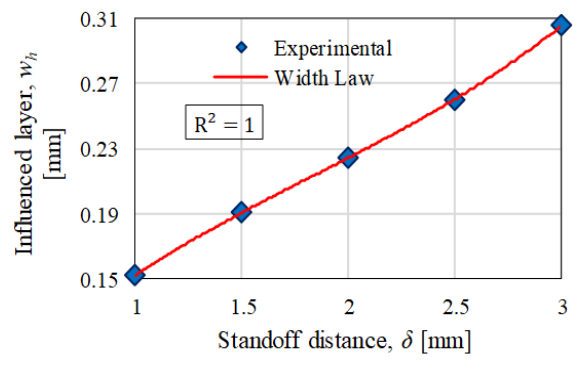
Figure 11. Chart of hardened layer width [11]